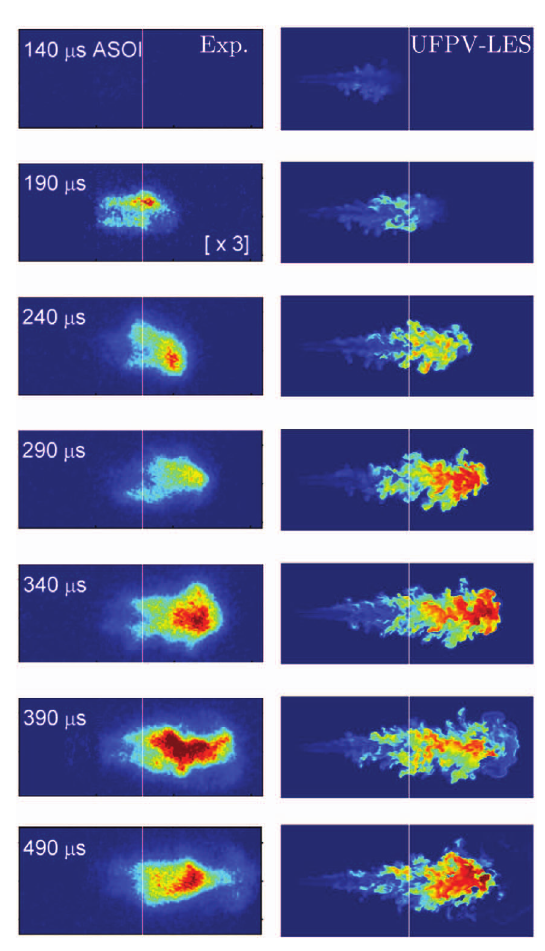
Fig. 8. Measured CH 2 O PLIF signal [58] (left column) in comparison with the CH 2 O mass fraction obtained by the UFPV-LES approach (right column). Vertical white line denotes measured steady lift-off length of 16.10 mm [56]. Experimental data reprinted from Skeen et al. [58], with permission from